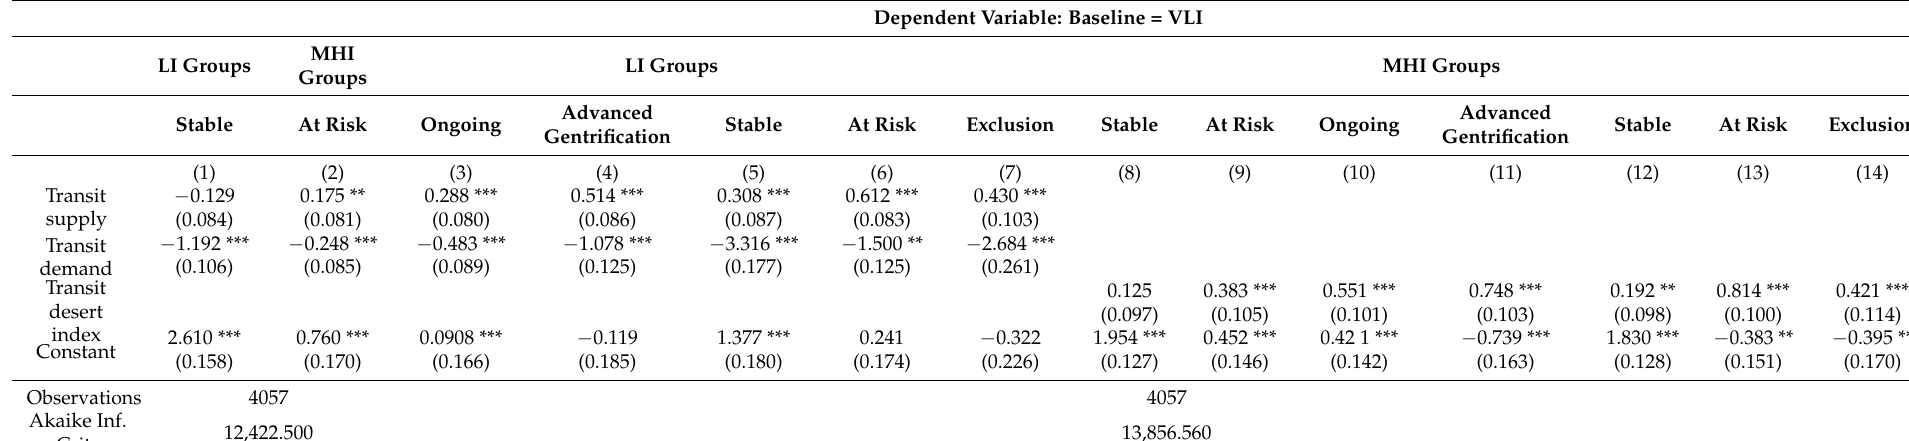
Table 5. Results of logit models by